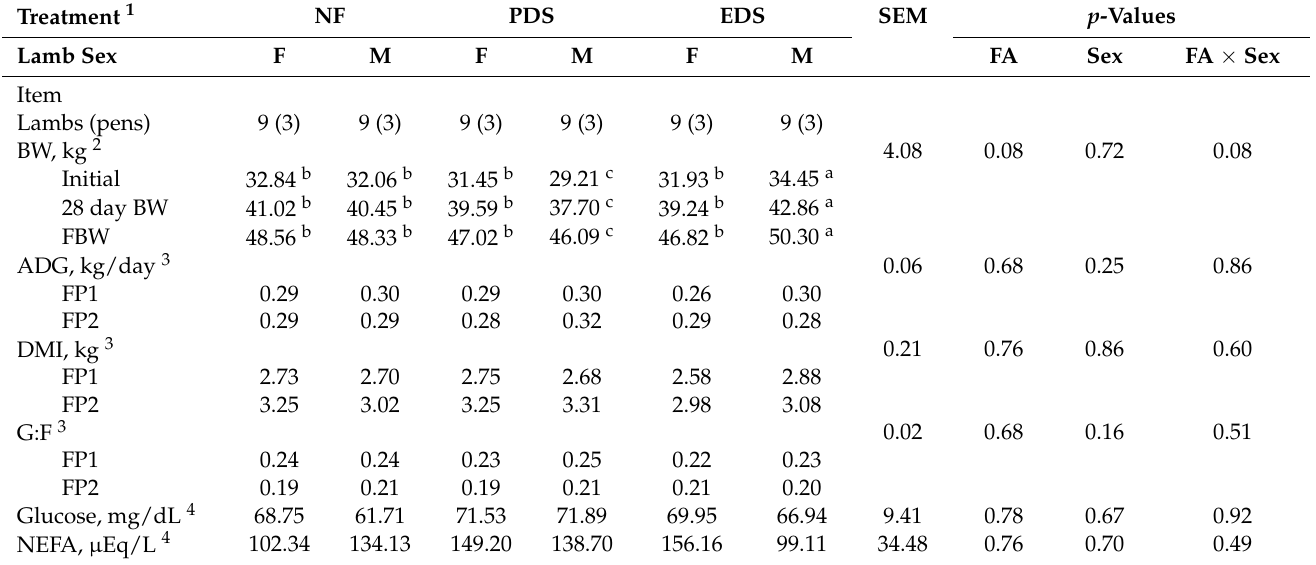
Table 7. Effect of a fatty acid enriched diet during the last 50 days of gestation on offspring development and plasma metabolites during the finishing period in male (M) and female (F) lambs Treatment